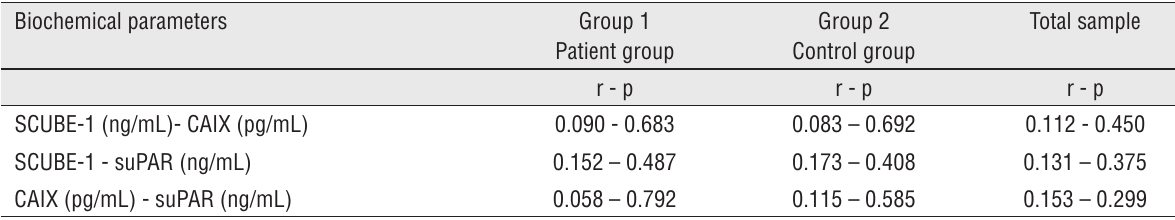
Table 3 - correlation analysis of biochemical parameters in patient, control group and total sample. Biochemical